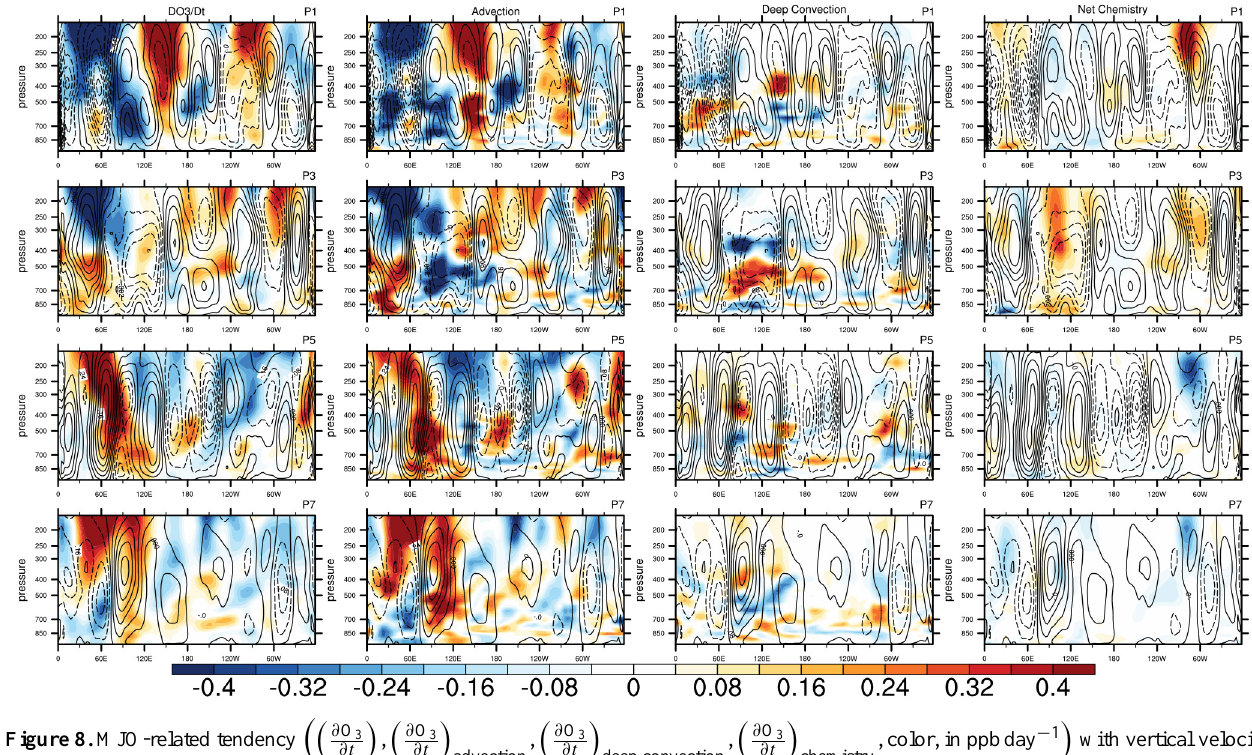
Figure 8. MJO-related tendency ties (dashed lines as negative and solid lines as